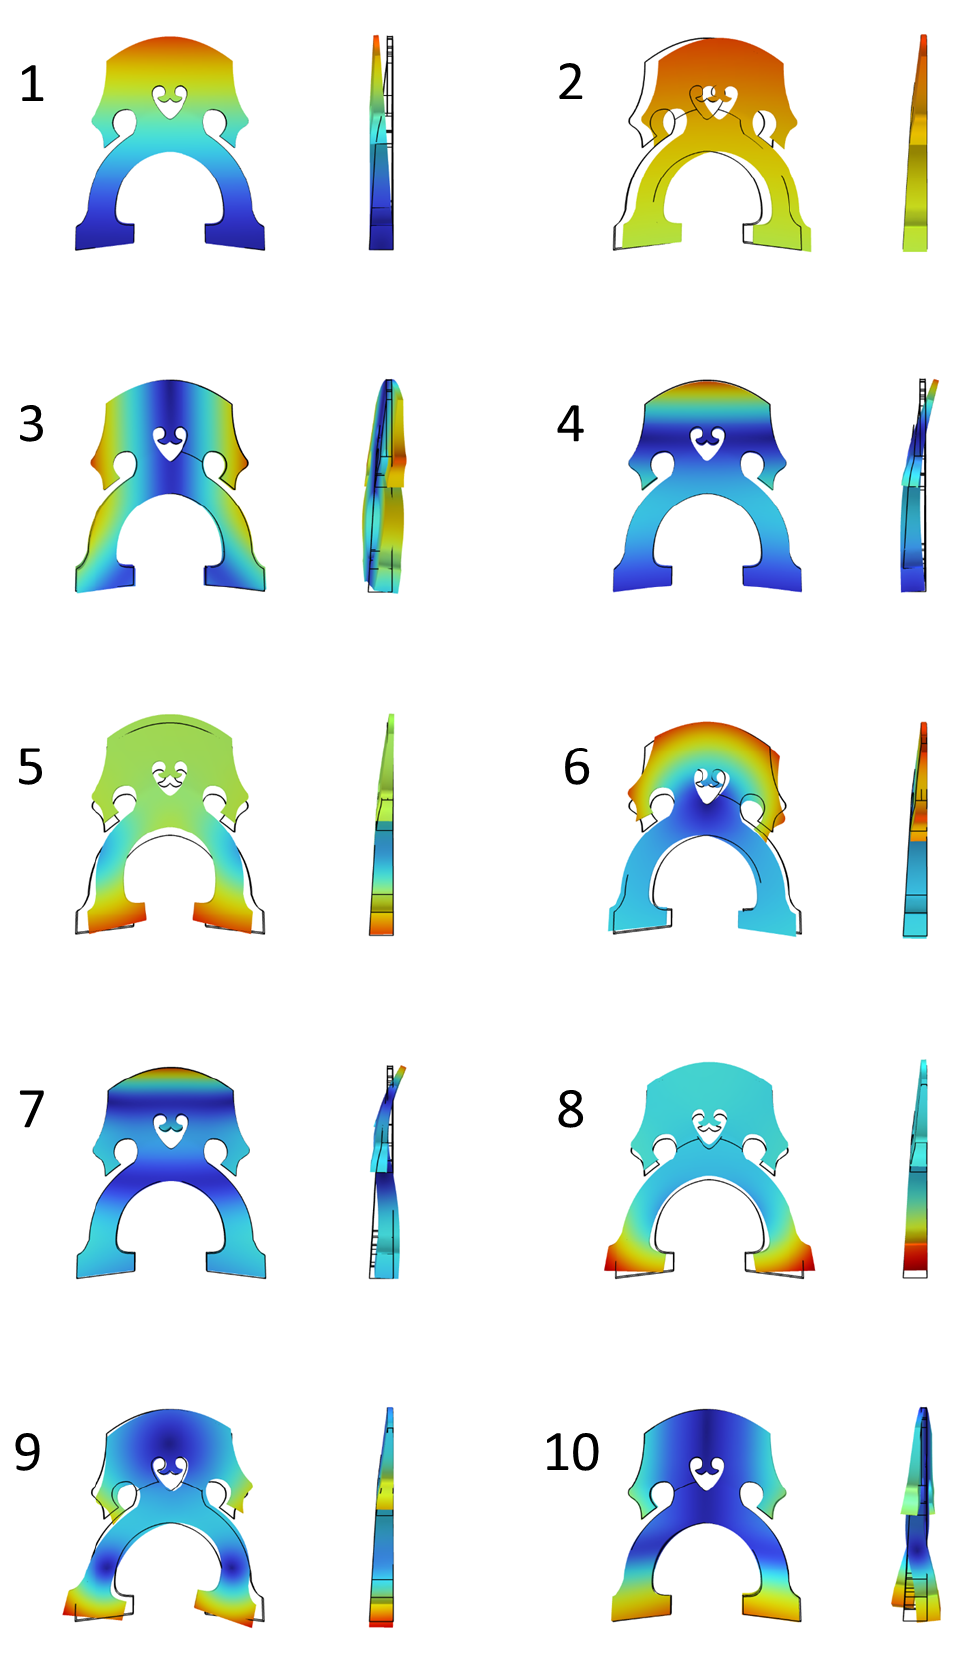
Figure A6. Mode shapes in spring boundary conditions (case (c)) for the Normal